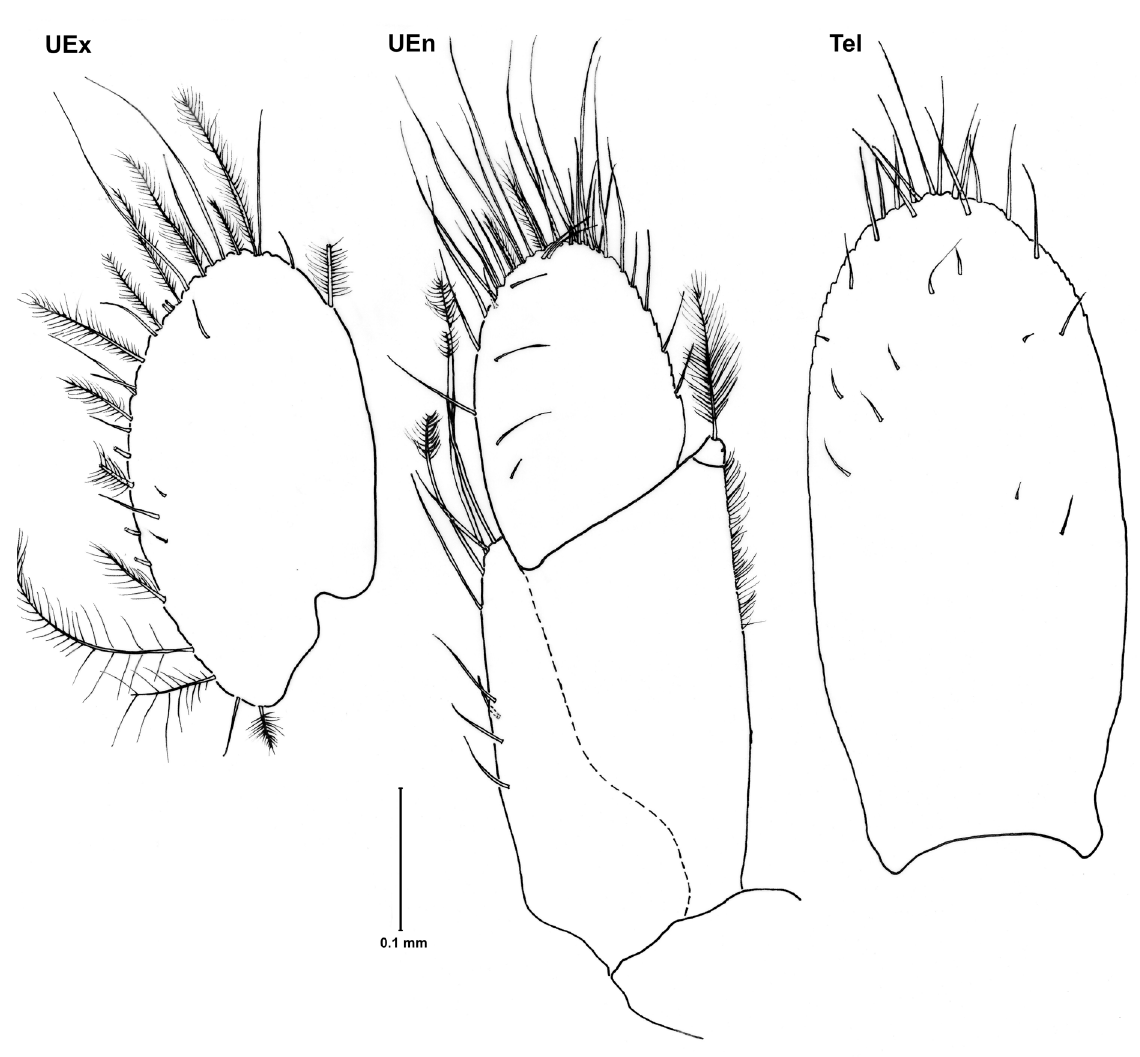
Fig. 34. Colanthura gerungi sp. nov., ♀, allotype (MZB Iso 110). Abbreviations: UEx = exopod of uropod; UEn = endopod of uropod; Tel